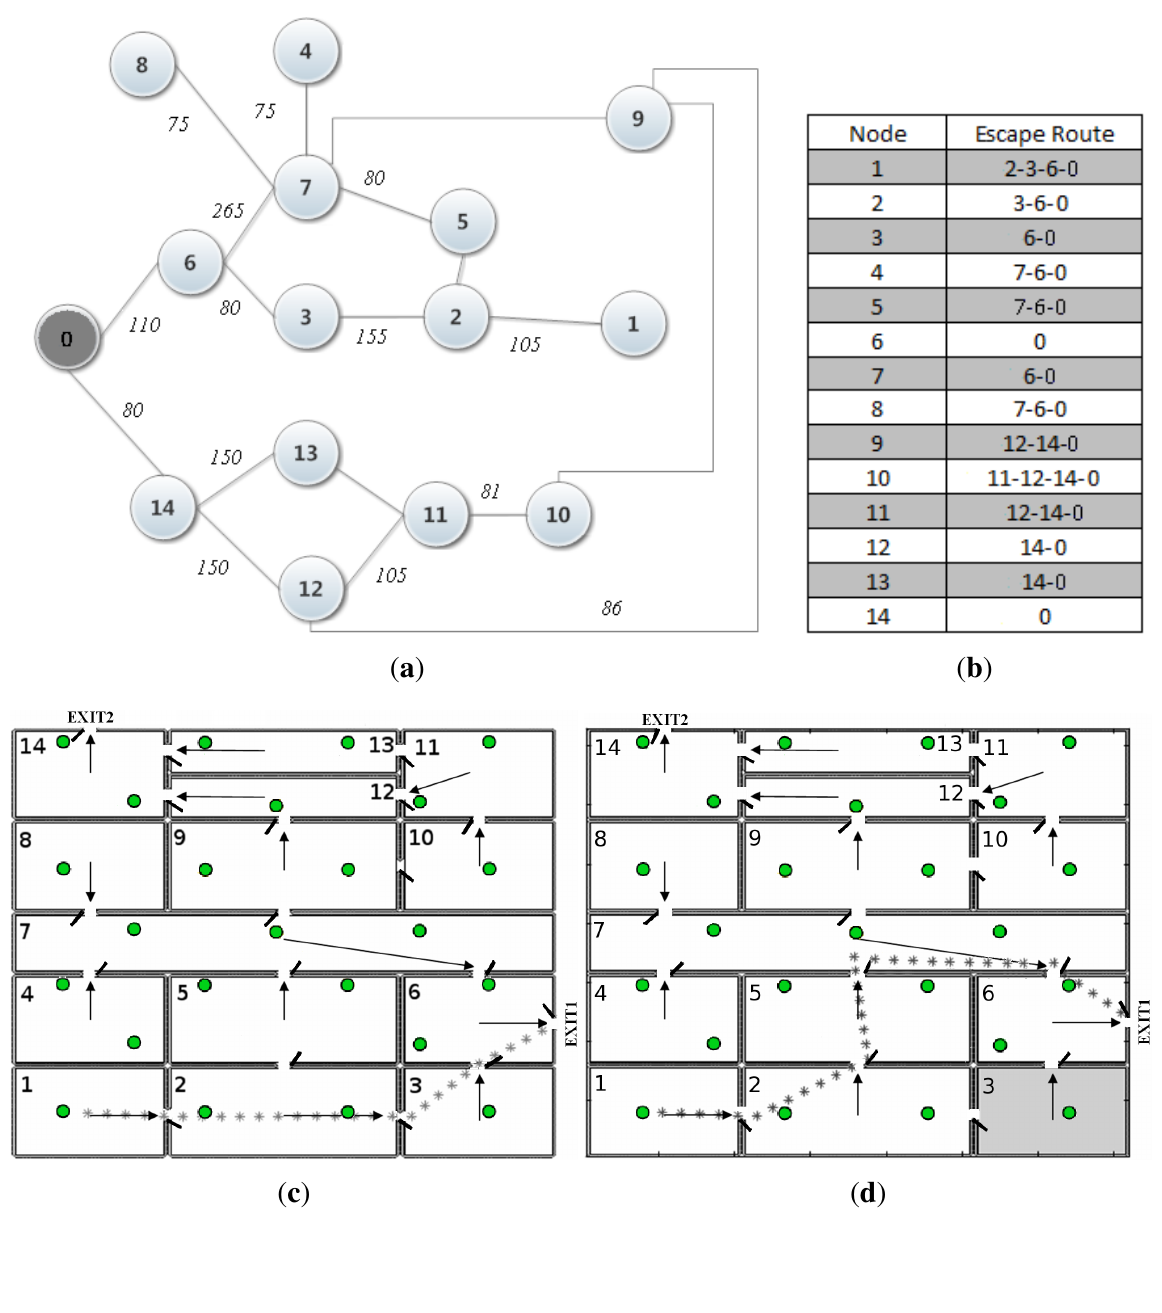
Figure 11. Dynamic firefighter guiding experiments carried out in the CONET testbed: ( a ) building graph; ( b ) optimal paths at t t , t and t ; ( f ) local guiding information at times t 1 2 3